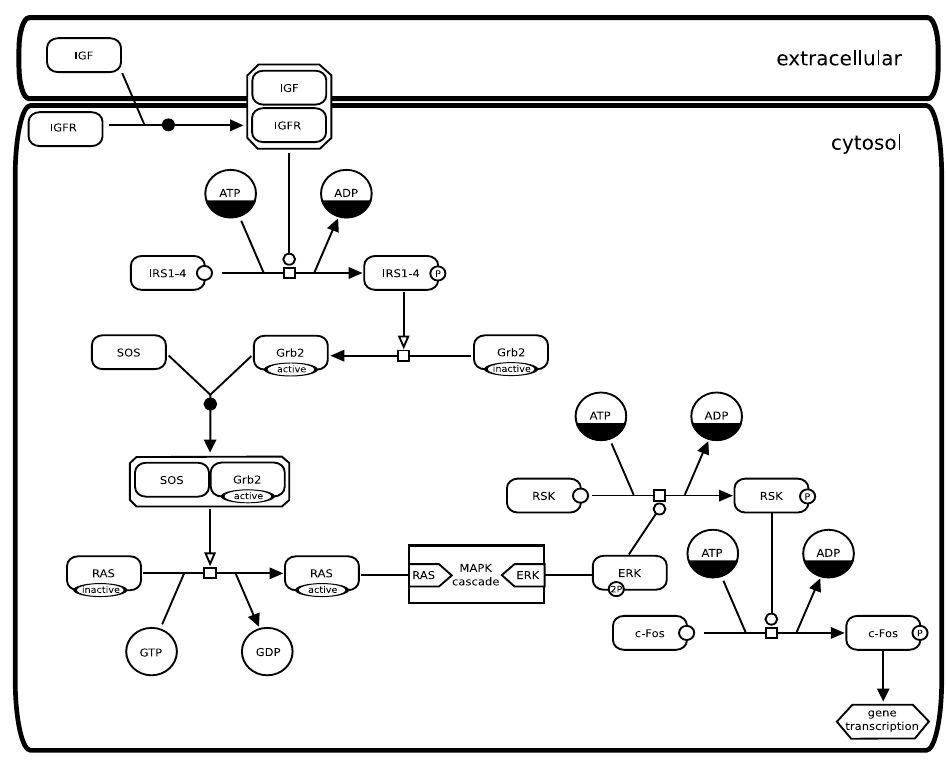
Figure A.2: Insulin-like Growth Factor (IGF) signalling. This example shows the use of compartments and how details can be hidden by using a submap. The submap is shown on Figure A.3 on the next